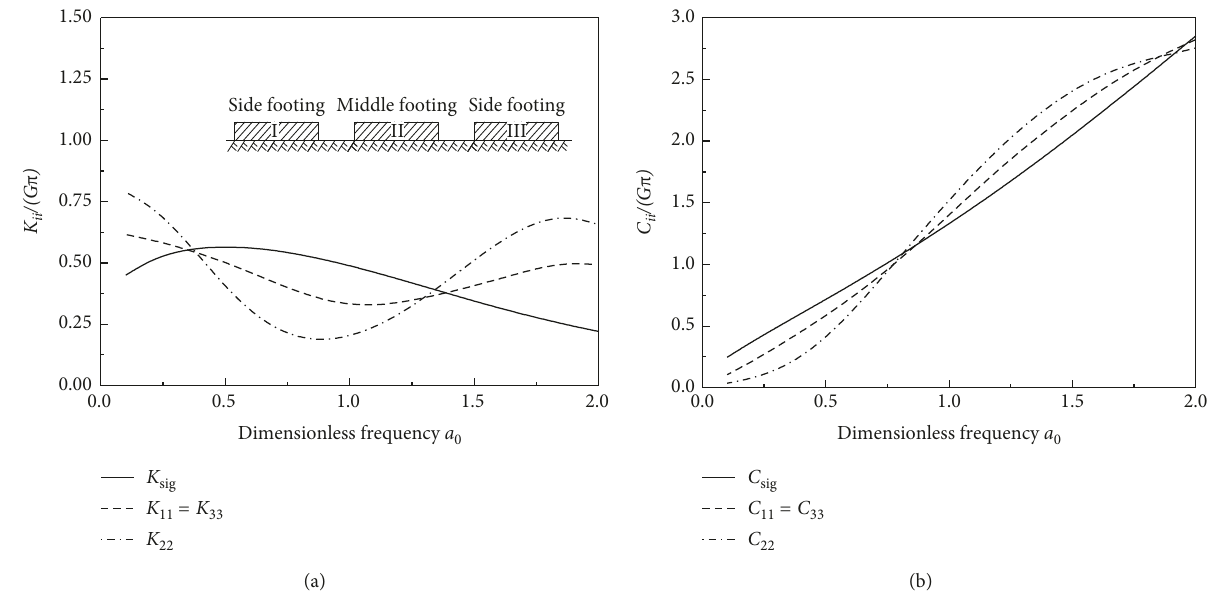
Figure 12: Vertical impedances of K ii and C ii in the impedance matrix. (a) Real part. (b) Imaginary